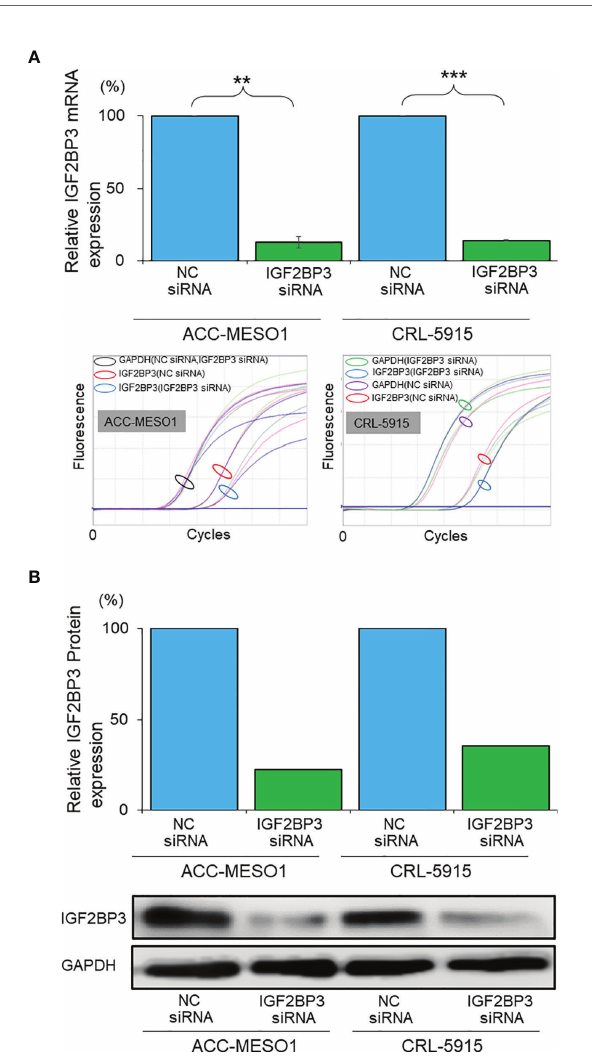
FIGURE 2 | Validation of IGF2BP3 knockdown. (A) Bar graph showing the relative IGF2BP3 mRNA expression in mesothelioma cell lines transfected with IGF2BP3 siRNA as compared with those transfected with NC siRNA (the lower panel represents the ampli fi cation curves of real time PCR experiments). (B) Bar graph showing the relative IGF2BP3 protein expression in mesothelioma cell lines transfected with IGF2BP3 siRNA as compared with those transfected with the NC siRNA (lower panel is an image of the western blot). NC, negative control; ** p < 0.01; *** p < 0.001.